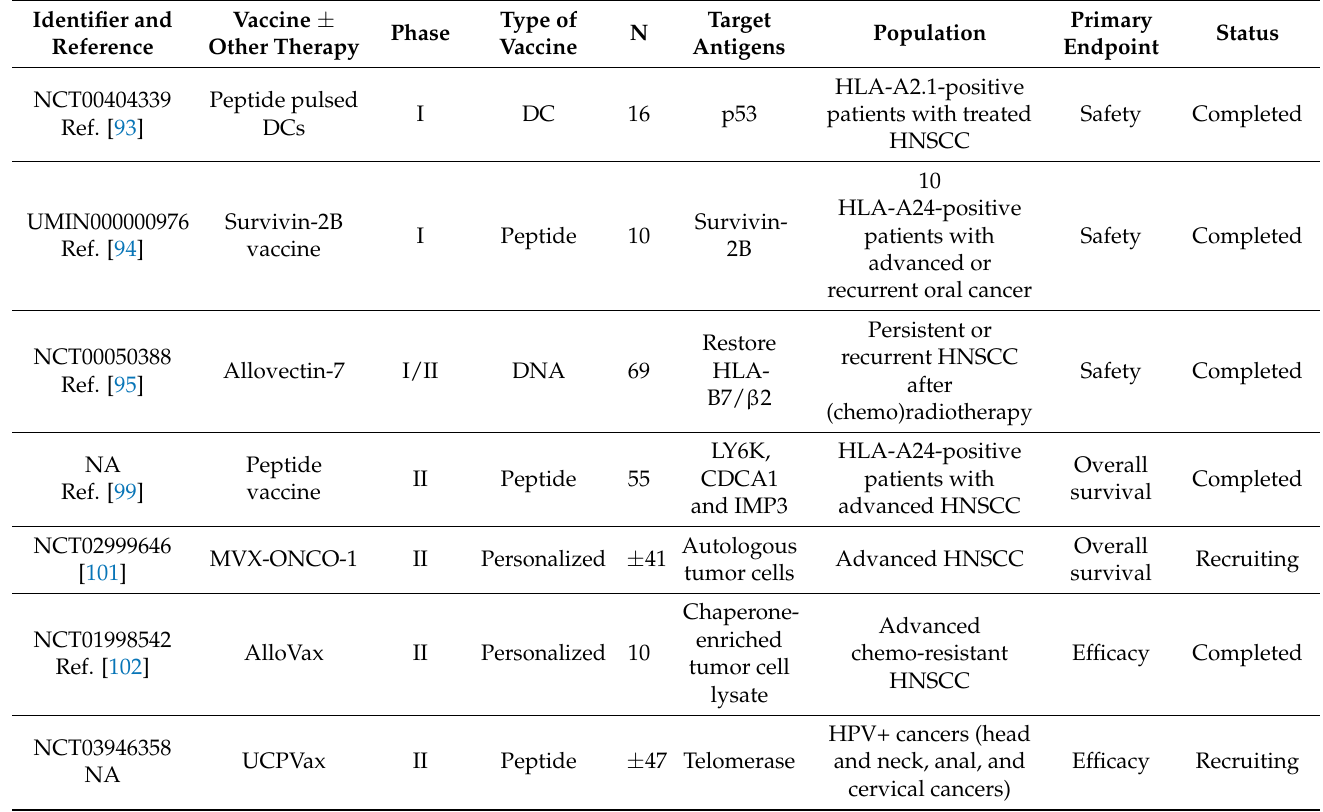
Table 3. Clinical trials in vaccines targeting non-viral